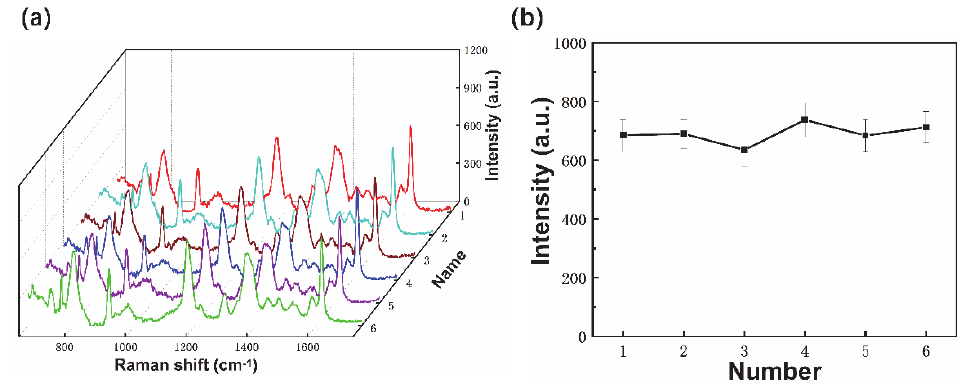
Figure 8. Raman spectra of 10 − 5 CV molecules ( a ) and 1619 cm − 1 peak intensities ( b ) using same batch fiber probes.